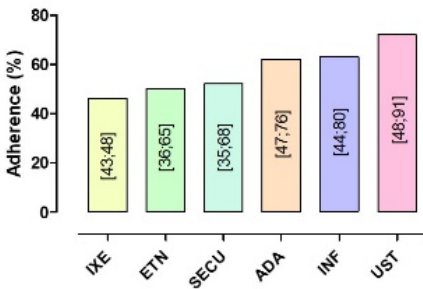
Figure 4. Percentage of adherent patients according to biological drugs. Confidence intervals (95%) are reported within the vertical bars.